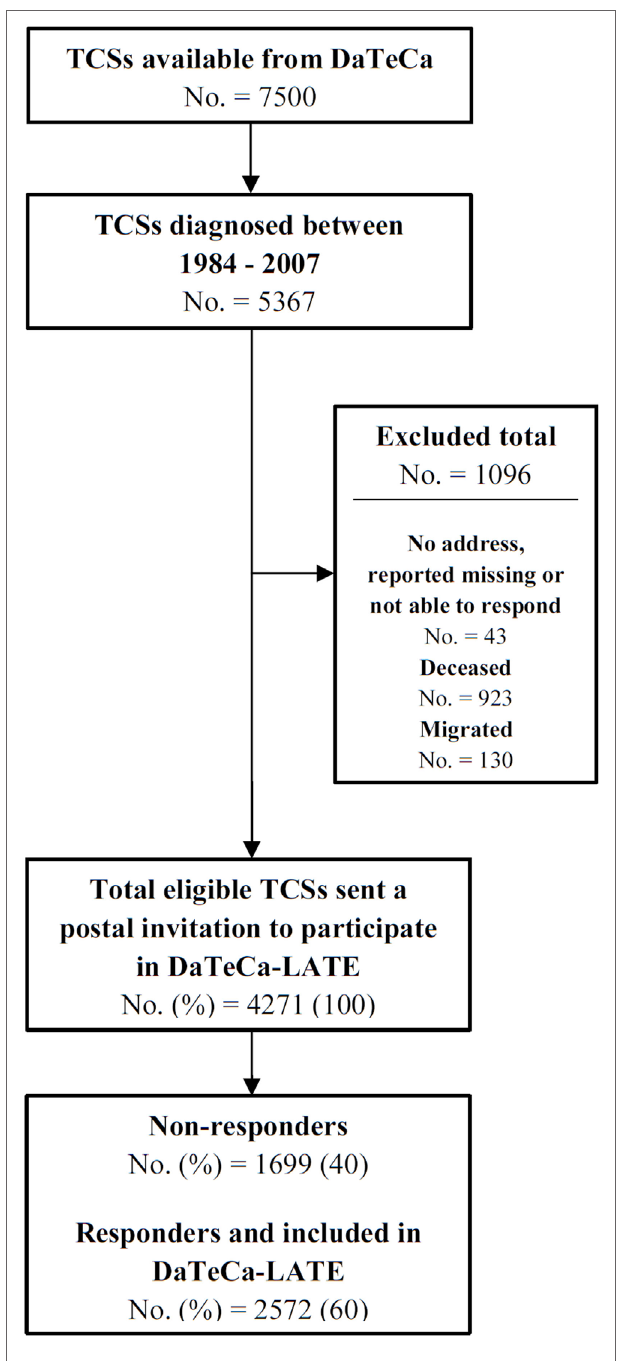
FigUre 2 | The Danish Testicular Cancer Late Treatment Effects Cohort (DaTeCa-LATE) flowchart.